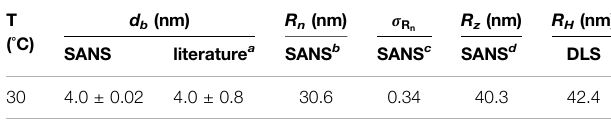
TABLE 2 | Summary of lipid vesicle characterization results from SANS and